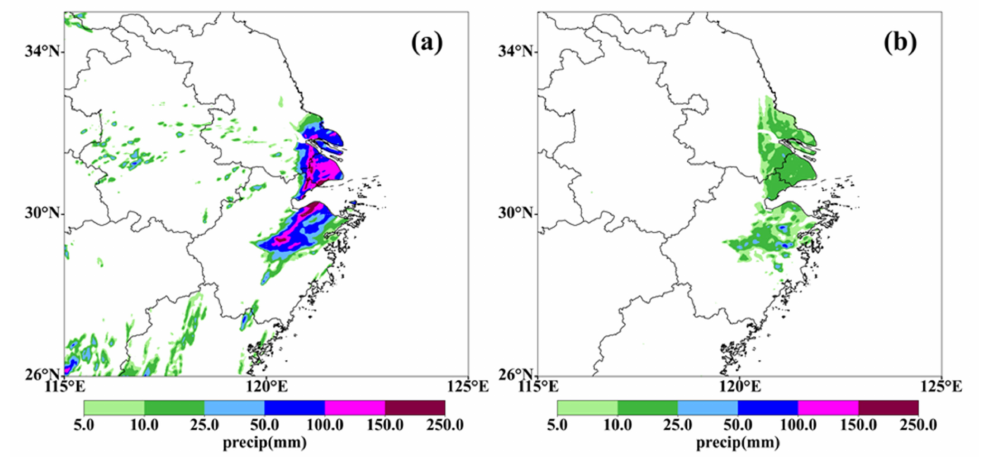
Figure 5. Cumulative rainfall from 20:00 BT 4 to 20:00 BT on 5 August 2020, simulation of 3 km domain (shaded area, unit: mm). ( a ) Normal simulation, ( b ) Simulation after closing the latent heat release of the inner 3 km grid.